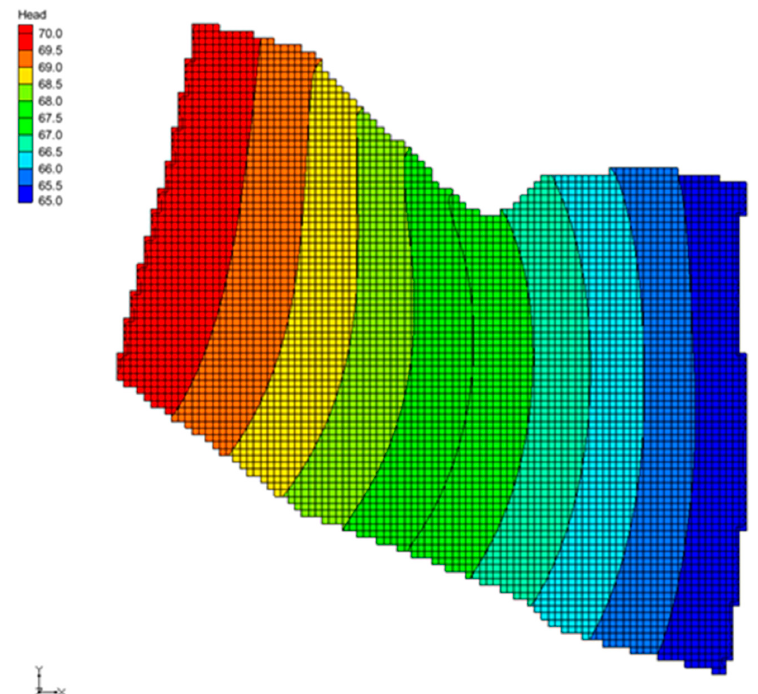
Figure 8. Groundwater level flow field at the end of the fitted time period. Table 4. Parameter table of the coupled groundwater solute transport model.